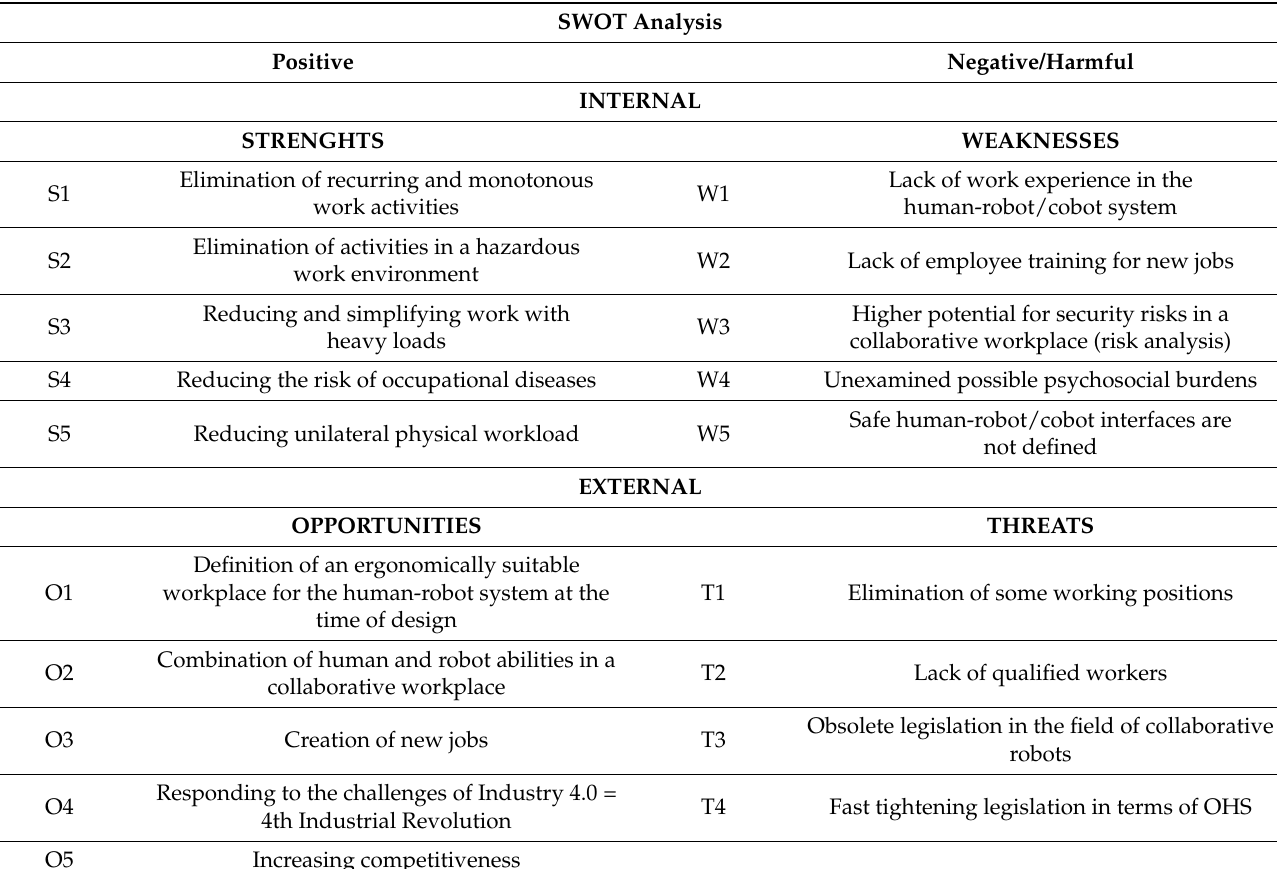
Table 2. SWOT (analysis of Strengths, Weaknesses, Opportunities, and Threats) analysis for the implementation of robotics in industrial settings (Source: own elaboration, 2019).